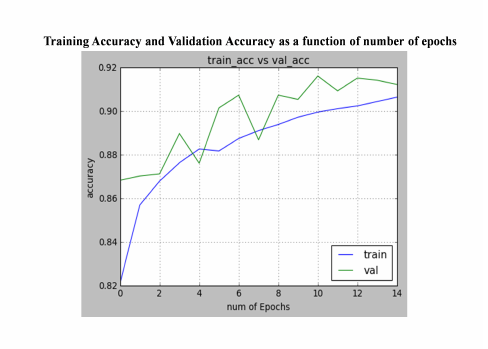
Figure 16: Training accuracy, validation accuracy as function of number of iterations and